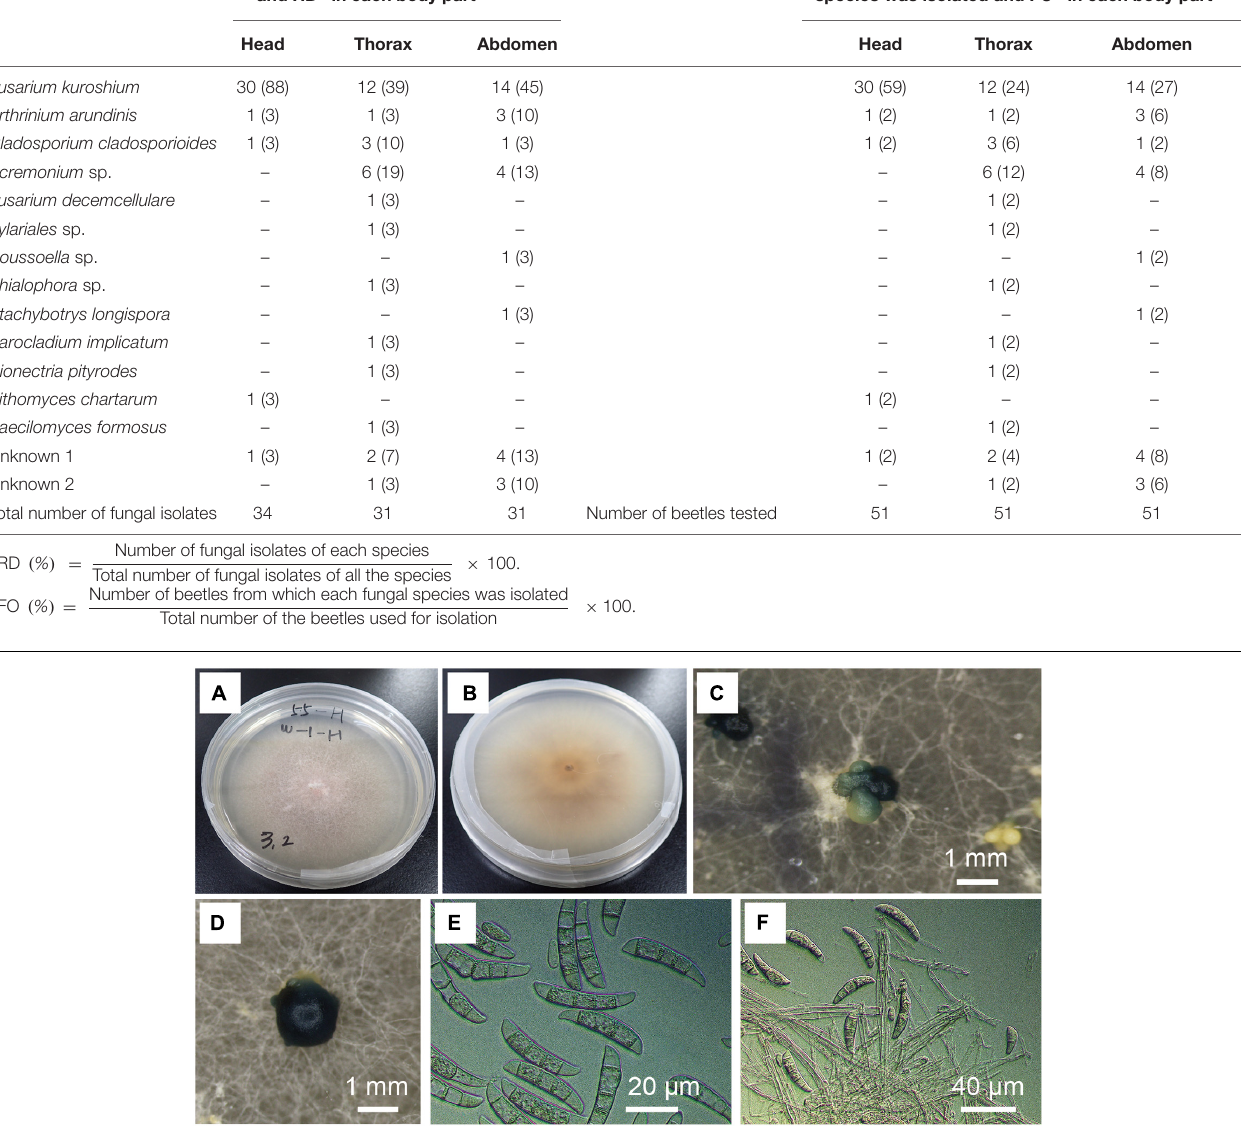
TABLE 2 | Relative dominance (RD, %) and frequency of occurrence (FO, %) of fungal species isolated from the head, thorax, and abdomen of female adults of Euwallacea interjectus in this study. Fungal species Number of fungal isolates and RD a in each body part